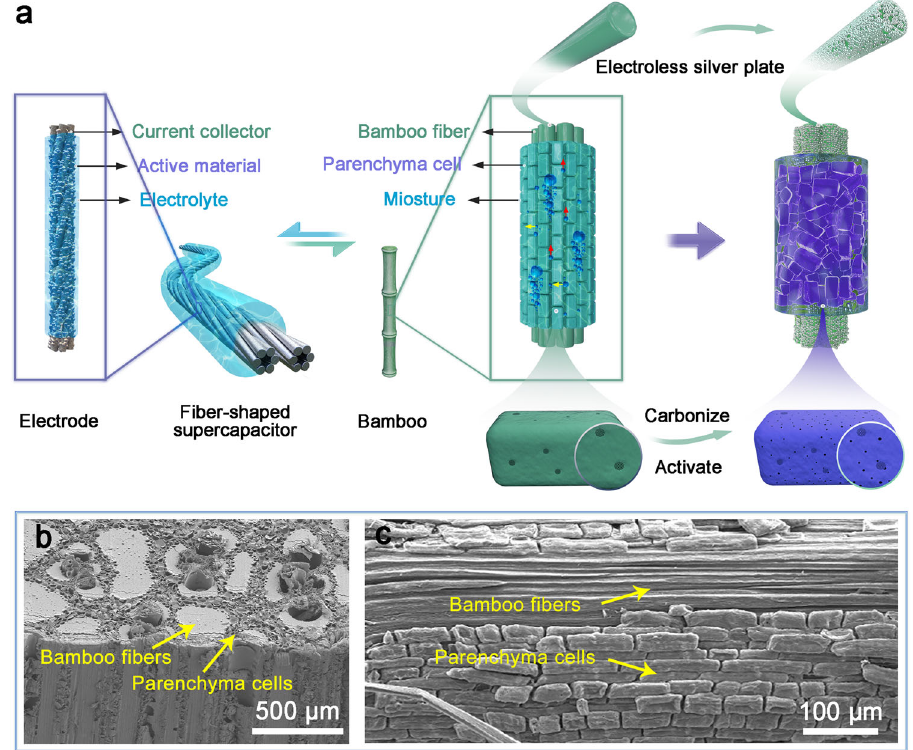
Fig. 1 Schematic of the design concept of fl exible bamboo-structured FSCs and the tissue structure of natural bamboo. a Process for fabricating the fl exible bamboo-structured FSCs. (b-c) SEM images of the natural bamboo: b top and cross-section of the natural bamboo, c cross-section showing the structural relationship between FCs and PCs in the natural